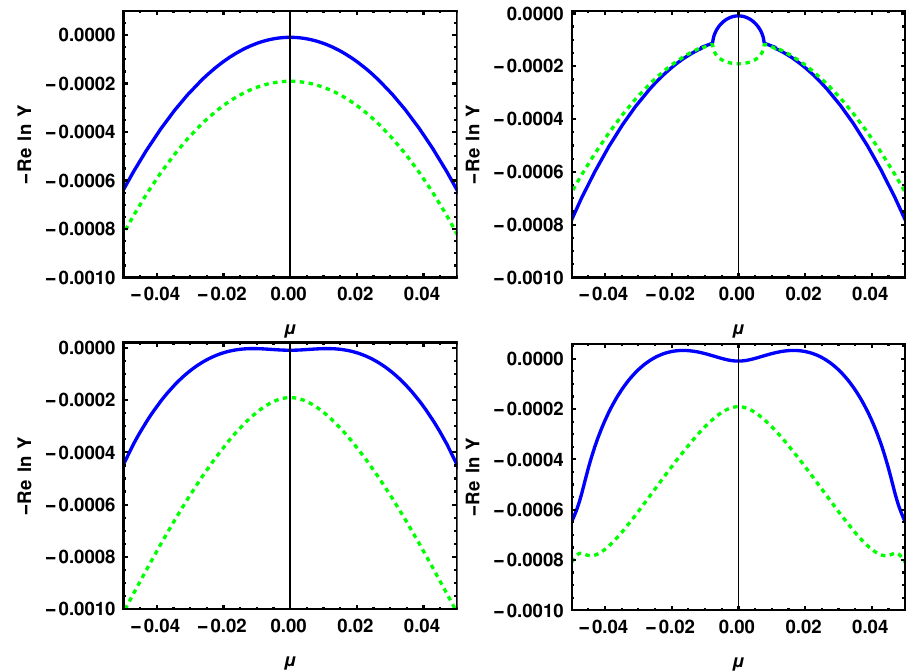
Figure 4. Curves of pseudocontinuous spectrum in the limit of large delay (21) of (12) of the CW with the largest intensity ( | A 0 | ≈ 0.0169 out of another two | A 0 | ≈ 0.0167 and | A 0 | ≈ 0.006) near the LLE limit, η ≈ 1.707 × 10 − 6 , and varying β = 0 ( top-left ), β = 1/4 ( top-right ), β = − 1/8 ( bottom-left ), β = − 1/4 ( bottom-right ). Other parameters are as in Figure